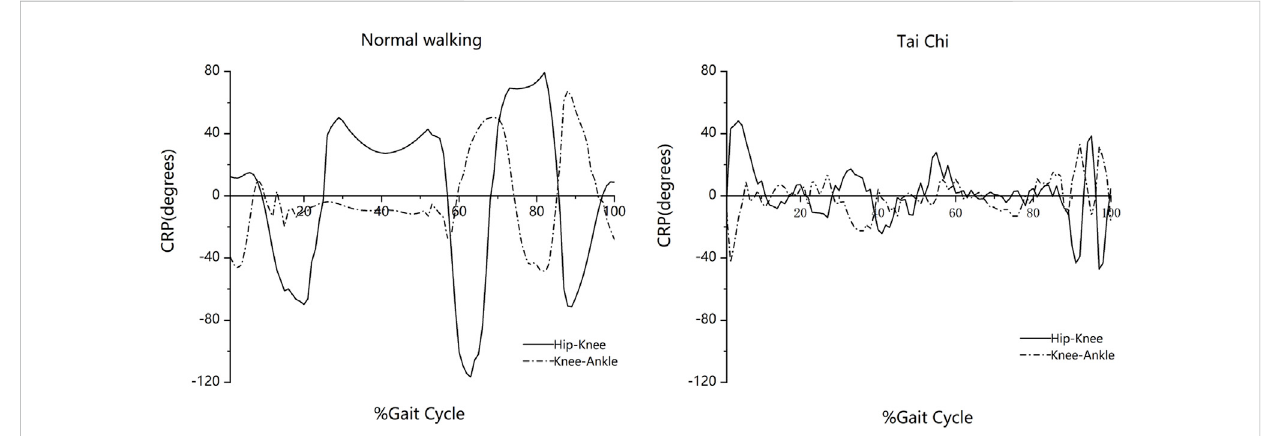
FIGURE 5 Continuous Relative Phase of the lower limb in the sagittal plane for normal walking and Tai Chi movements.